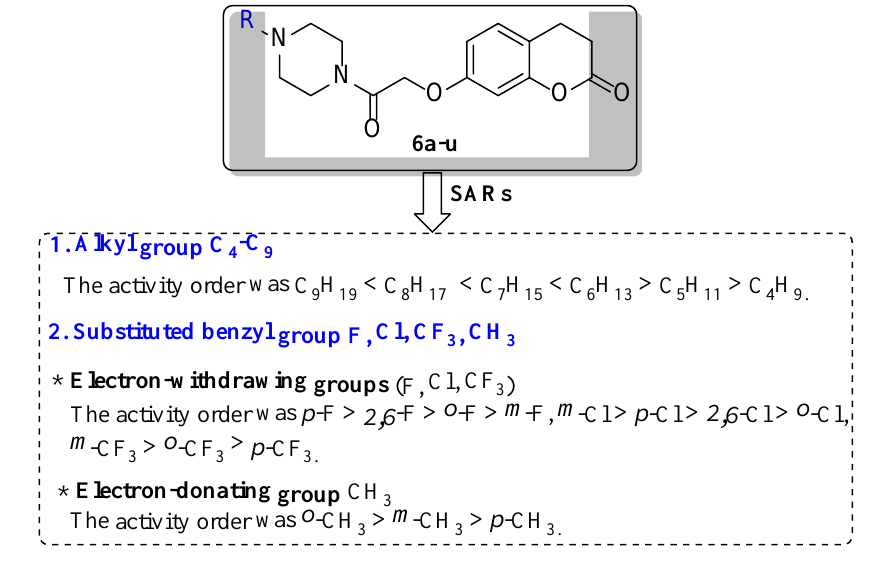
Figure 6. SARs of target compounds 6a–u.